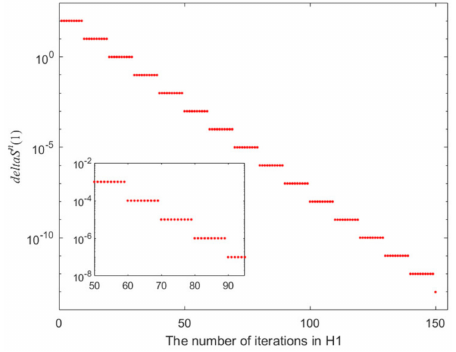
Figure 10. Stepped decrease of deltaS n